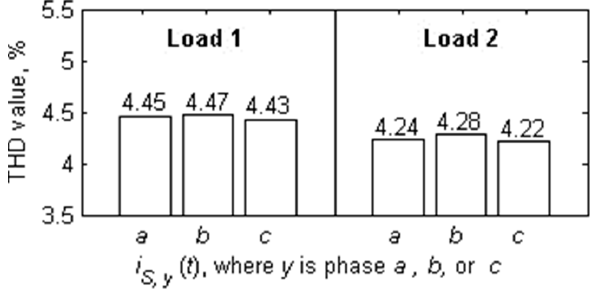
Figure 18. THD values of steady ‐ state 3 ‐ phase (cid:1861) (cid:3020) (cid:4666)(cid:1872)(cid:4667) after the SAPF implementation.